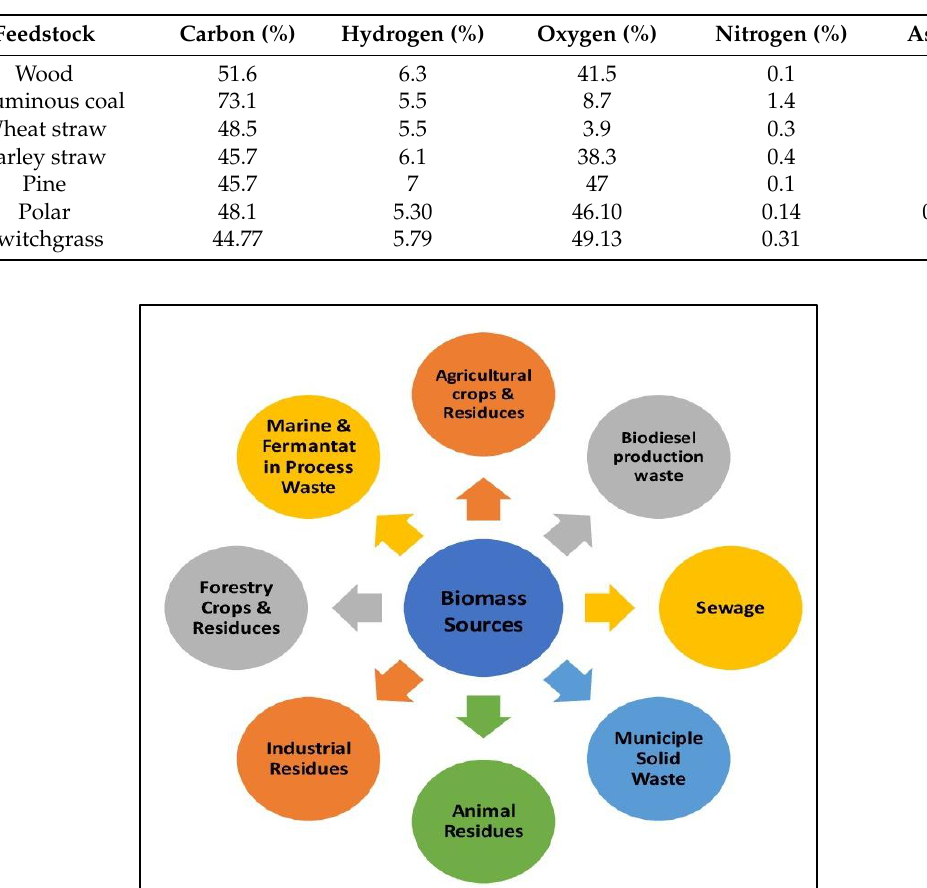
Figure 4. Available sources of biomass [61]. Table 1. Physical characteristics of biomass [9].